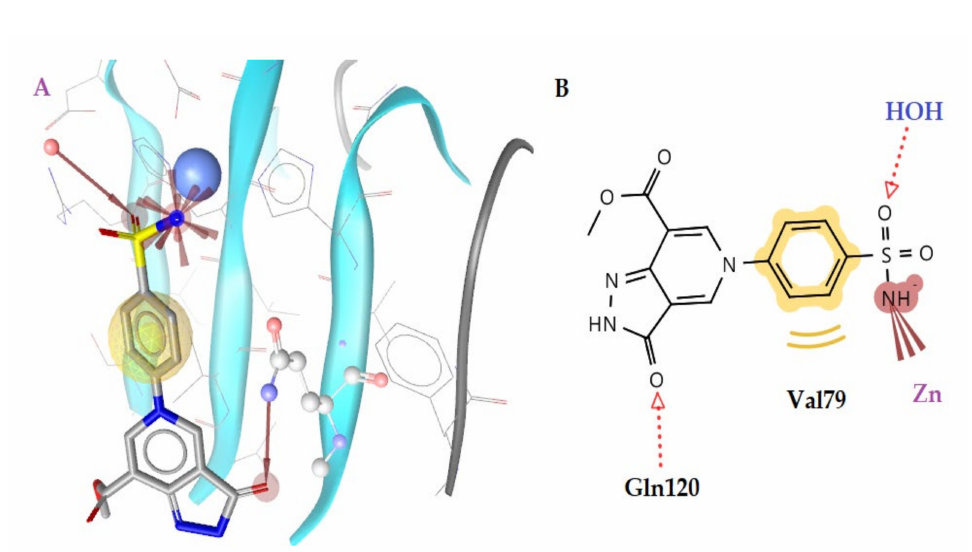
Figure 9. ( A ) Docking pose of compound 1b in γ -CA enzyme. ( B ) 2D interaction diagram of compound 1b. Active site zinc shown as blue sphere, water molecule shown as red sphere, red dotted arrows indicate H-bonds, and yellow spheres hydrophobic are